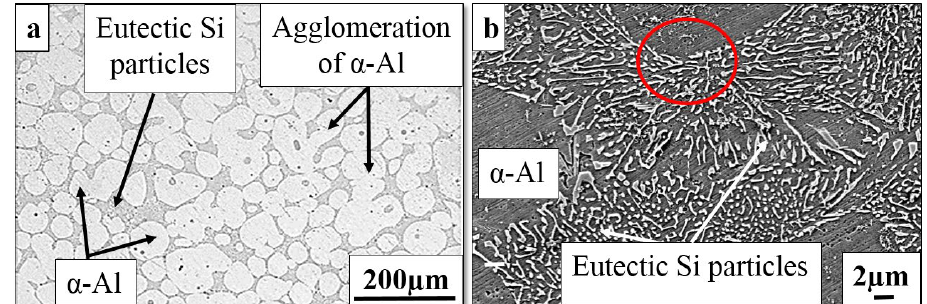
Figure 3. Microstructural features of thixoformed Al–7Si alloy by ( a ) optical micrograph and ( b ) SEM morphology of eutectic Si.